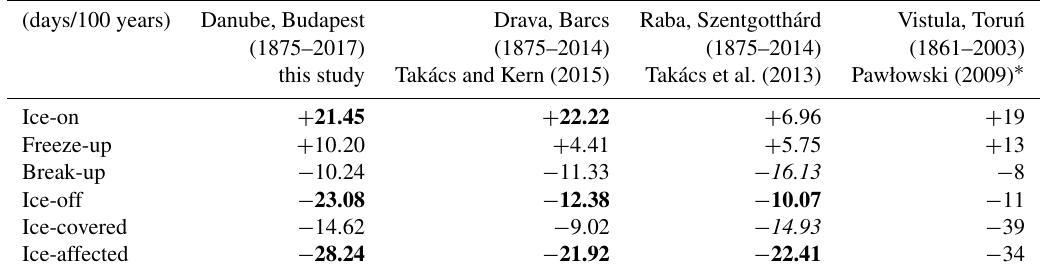
Table 5. Changes in the ice regime of the rivers Danube, Drava, and Raba. (Values with p < 0 . 05 are shown in bold, and p < 0 . 10 values are given in